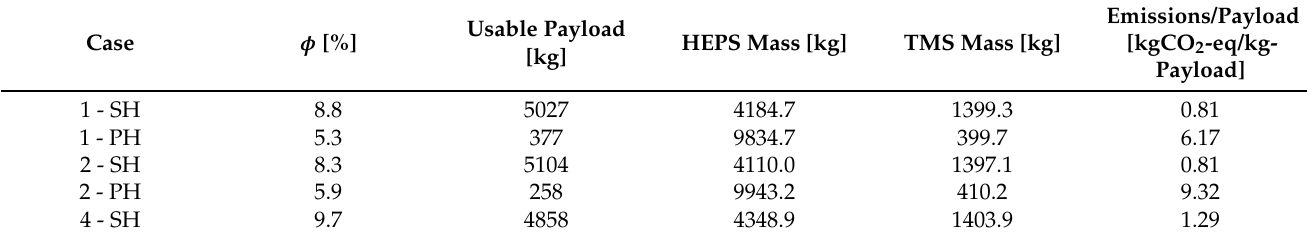
Table 8. Usable payload, HEPS mass, TMS mass, and CO 2 -eq emissions per kilogram of payload near the feasibility limits 1 and 2 for the analyzed cases, excluding infeasible